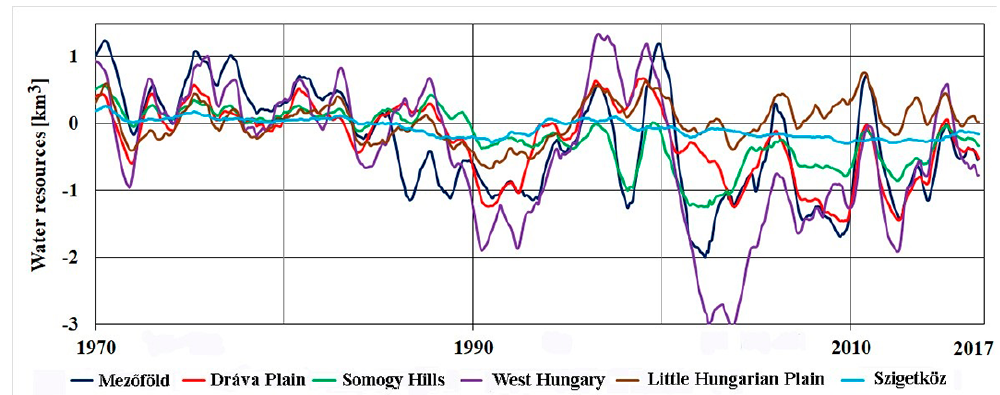
Figure 6. Changes in water resources in the areas west of the Danube